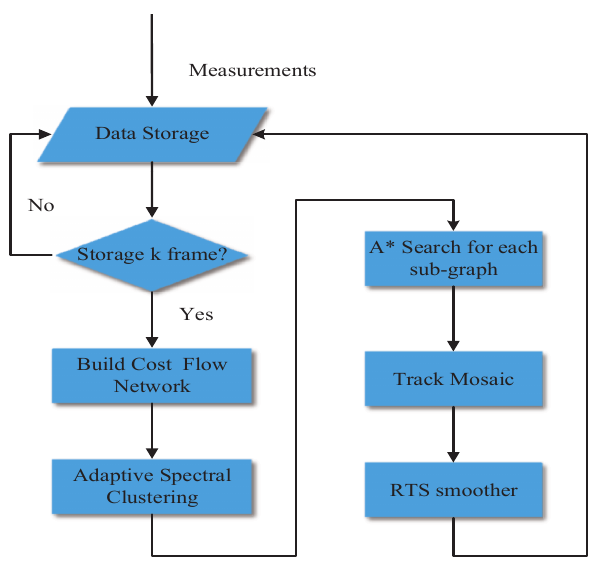
Figure 2. The flow chart of multitarget tracking algorithm based on adaptive network graph